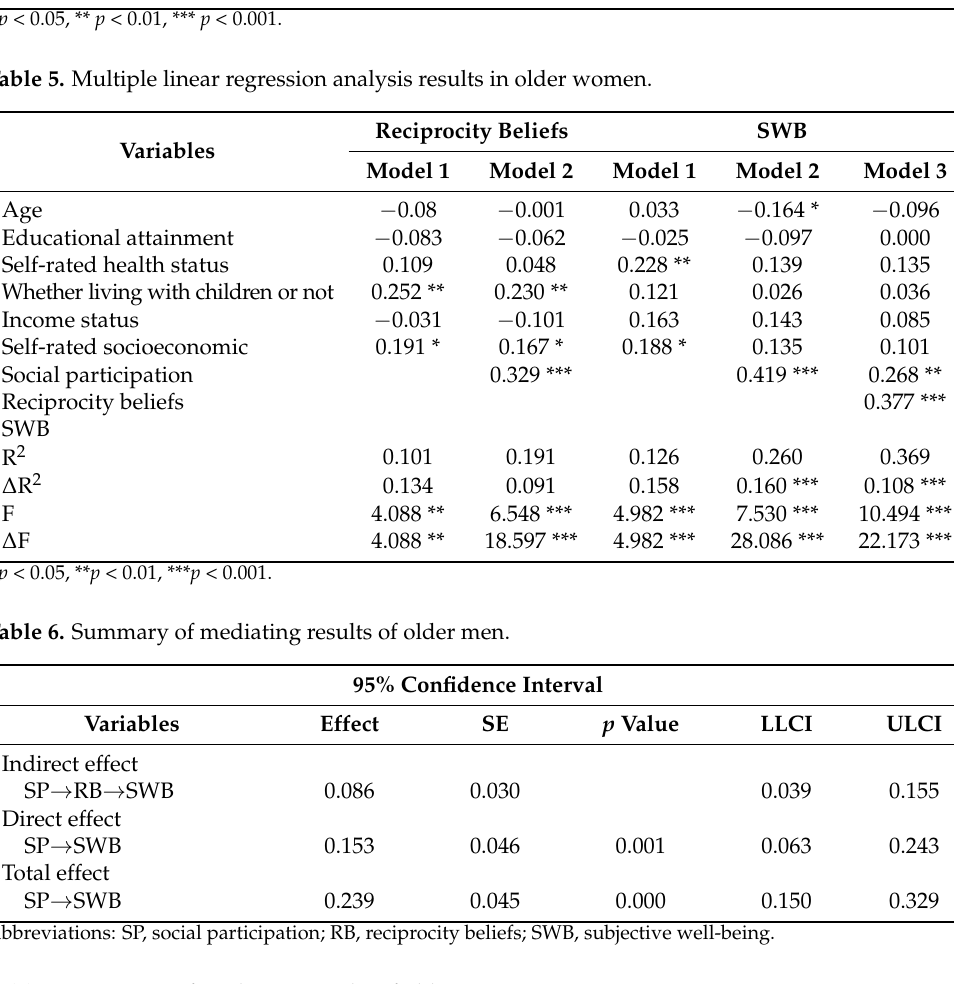
Table 7. Summary of mediating results of older